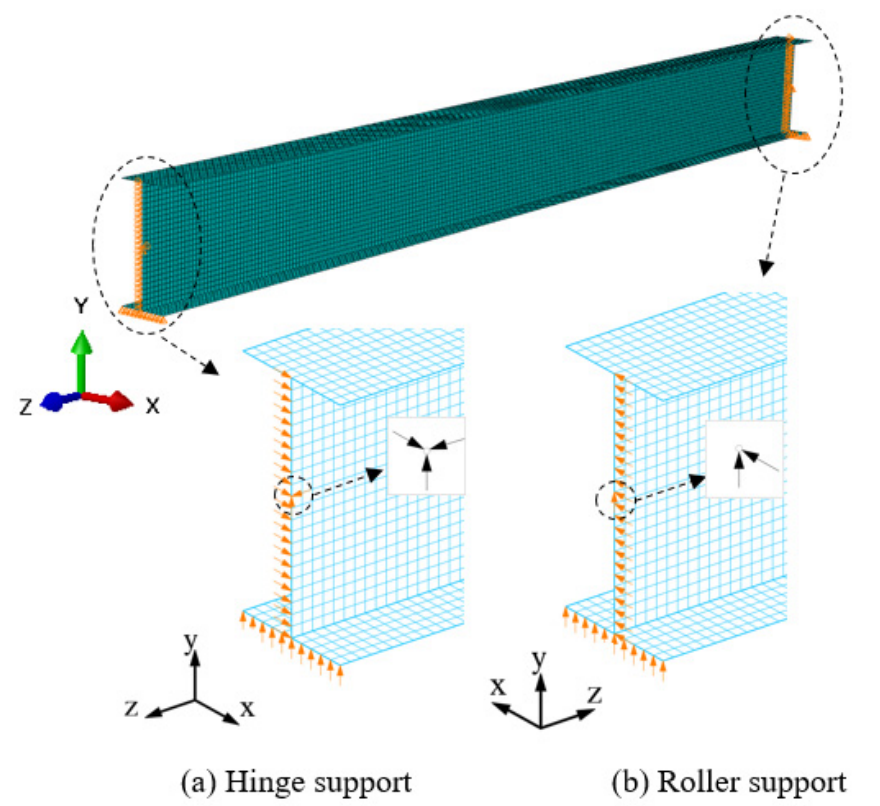
Figure 3. Beam model and boundary conditions.